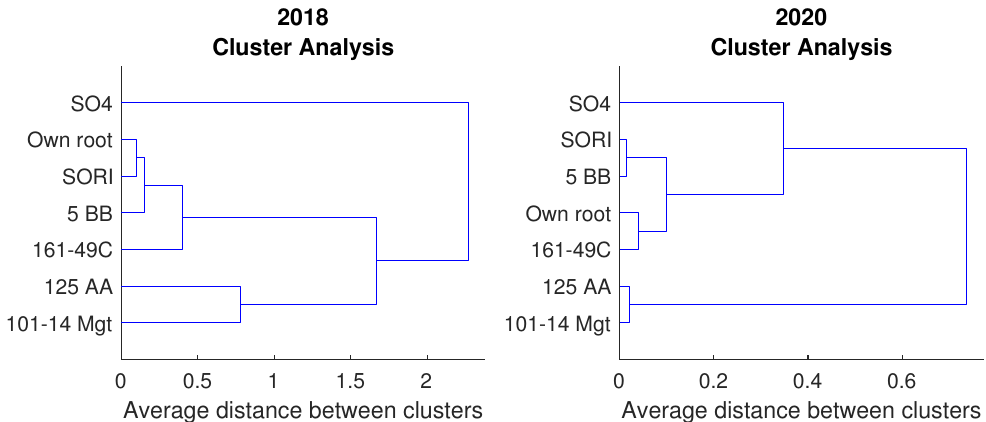
Figure 1. Cluster analysis of Regent grape fruit extract considered in the extreme years of the study.